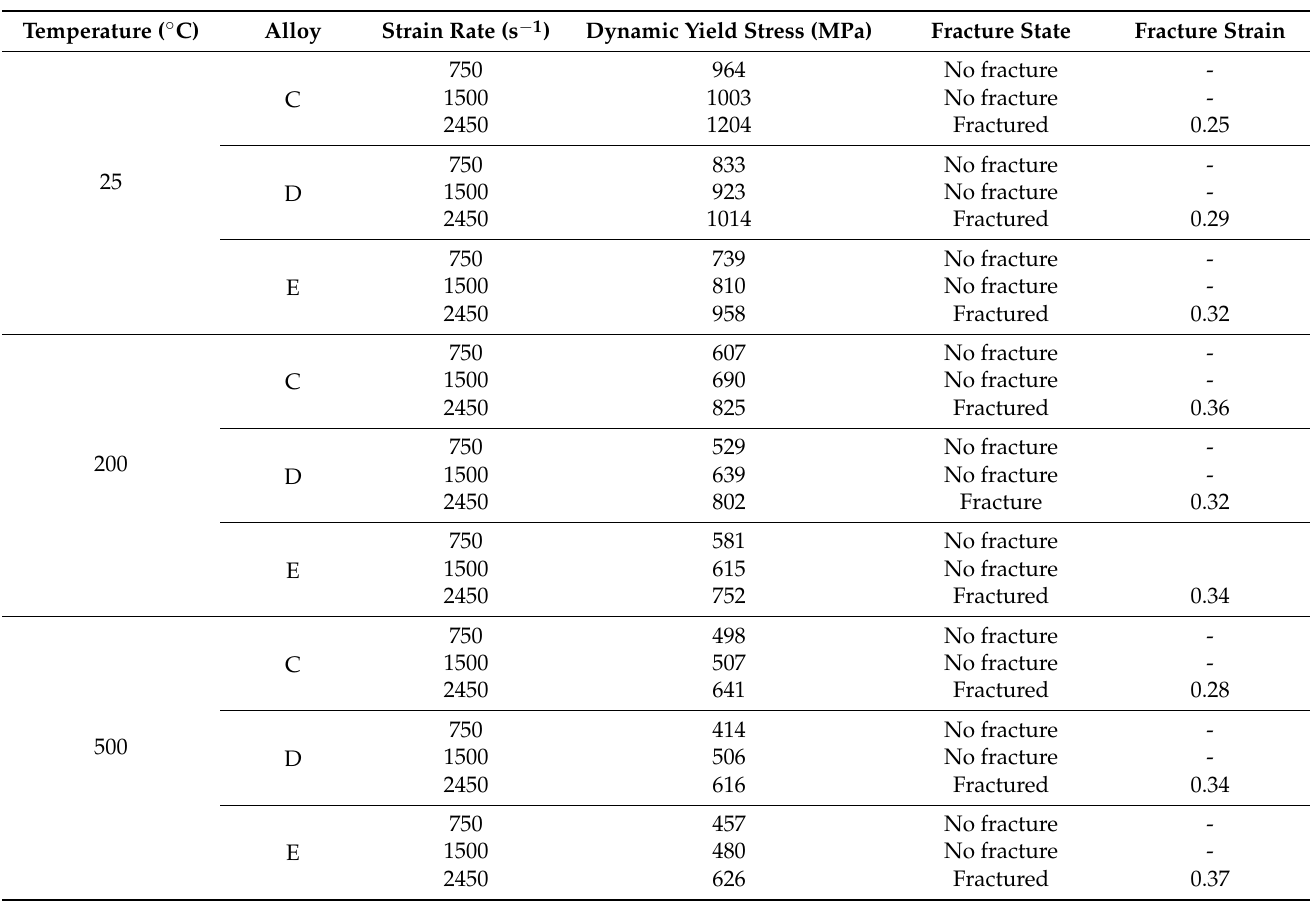
Table 3. Strain rates, yield stress, state of fracture and fracture strain for the high strain rate flow stress curves of samples C, D and